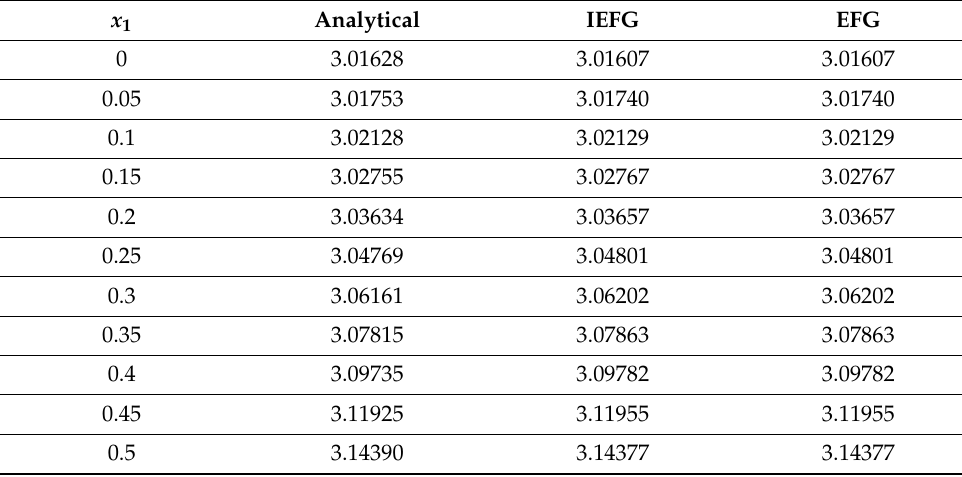
Table 3. The exact and numerical solutions of u (8/20, x 2 , 1/20).